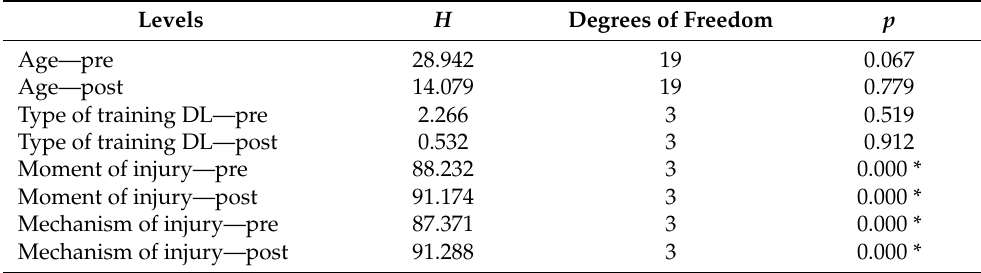
Table 4. Comparison of IRs between variables with three or more levels of BL and